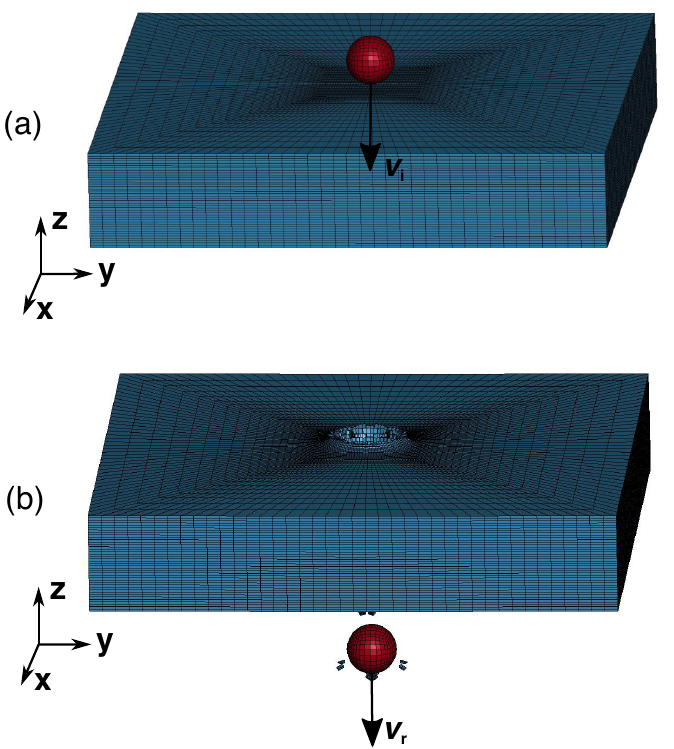
Figure 1. Schematic of the ballistic problem. ( a ) Initial setup of the projectile/plate system. ( b ) The system after perforation. The impact and the residual velocities of the projectile are denoted by v i and v r ,